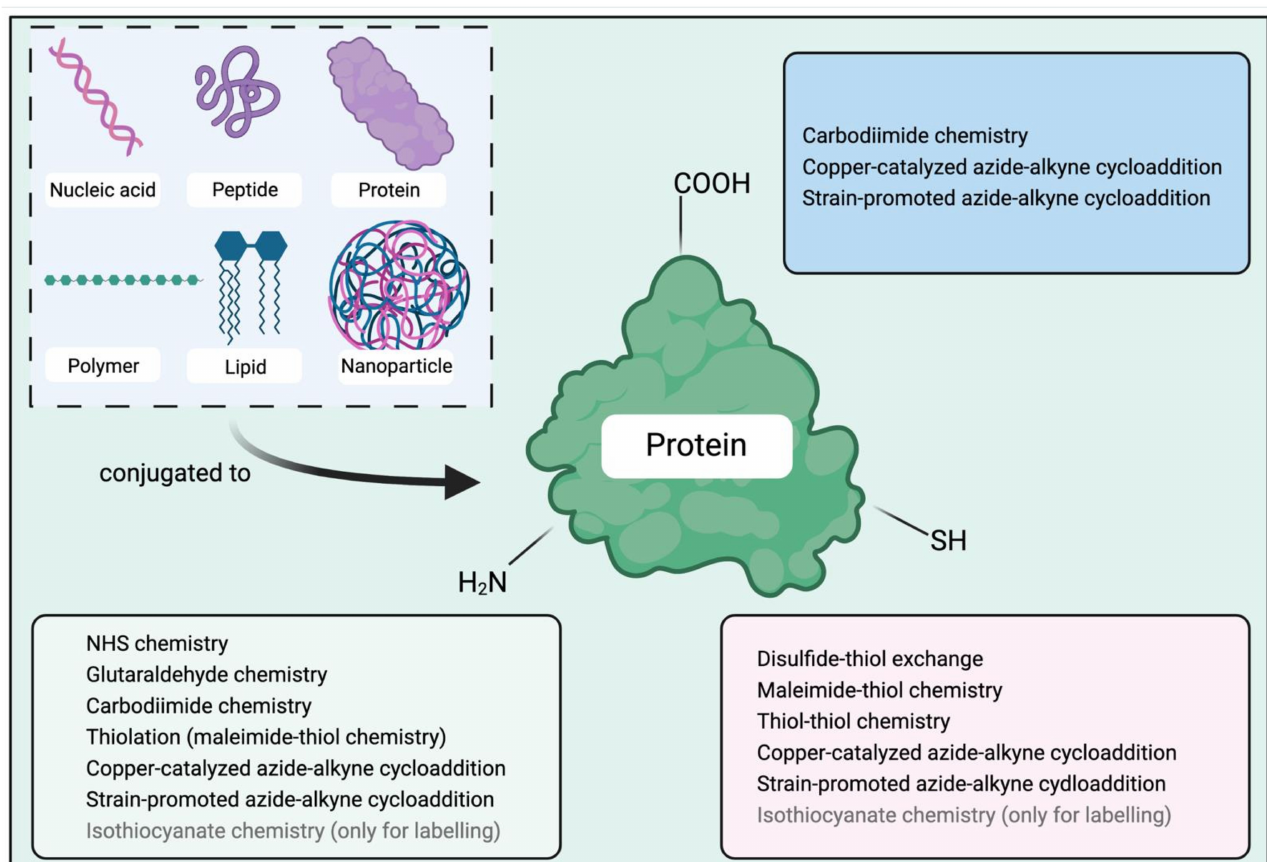
Figure 3. Conjugation strategies targeting different functional groups of proteins. Compounds, such as nucleic acids, peptides, proteins, polymers, lipids, and nanoparticles, can be conjugated to proteins via methods that target the amine, thiol, or carboxyl groups of proteins. NHS, N-hydroxysuccinimide. Drawing created with BioRender.com (accessed 26 May